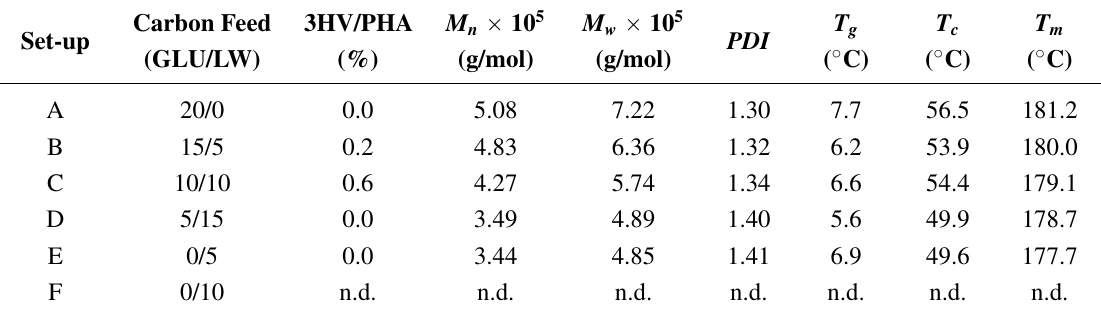
Table 1. Polymer data of the different shake flask